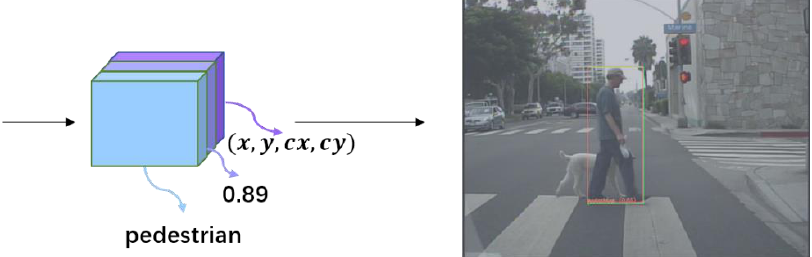
Figure 6. If the number of anchors in the experiment is assumed to be K , the dimension of the prediction tensor will be K ( 2 + 1 + 4 ) . Among them, 2 represents the number of categories, that is, pedestrian / not pedestrian, 1 represents confidence score, and 4 represents the coordinates of the bounding box.